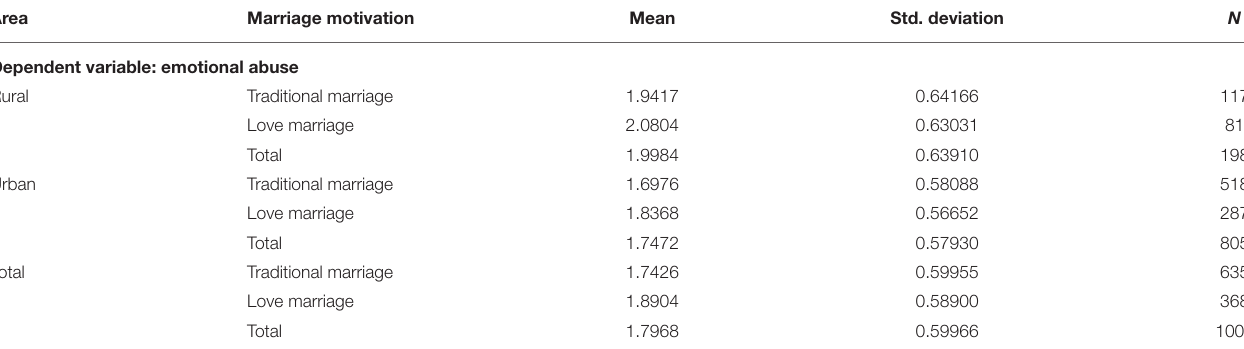
TABLE 6 | ANOVA: descriptive statistics.